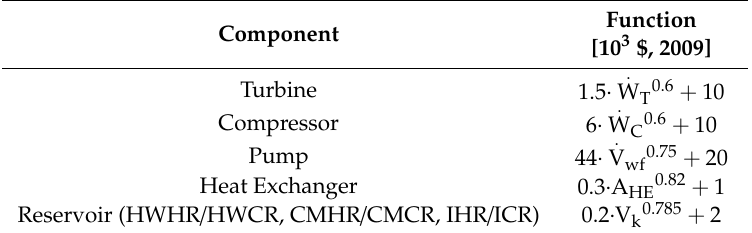
Table 3. Cost functions for the equipment